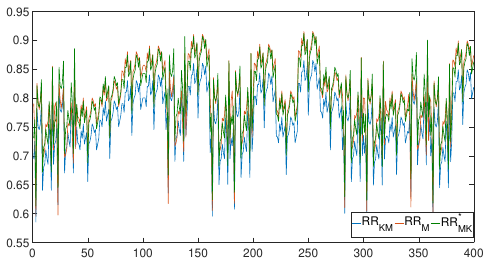
Figure 10. RR interval data for 20 samples from 20 different patients measured with Kardia Mobile (blue), MAC800 (red) and corrected Kardia Mobile